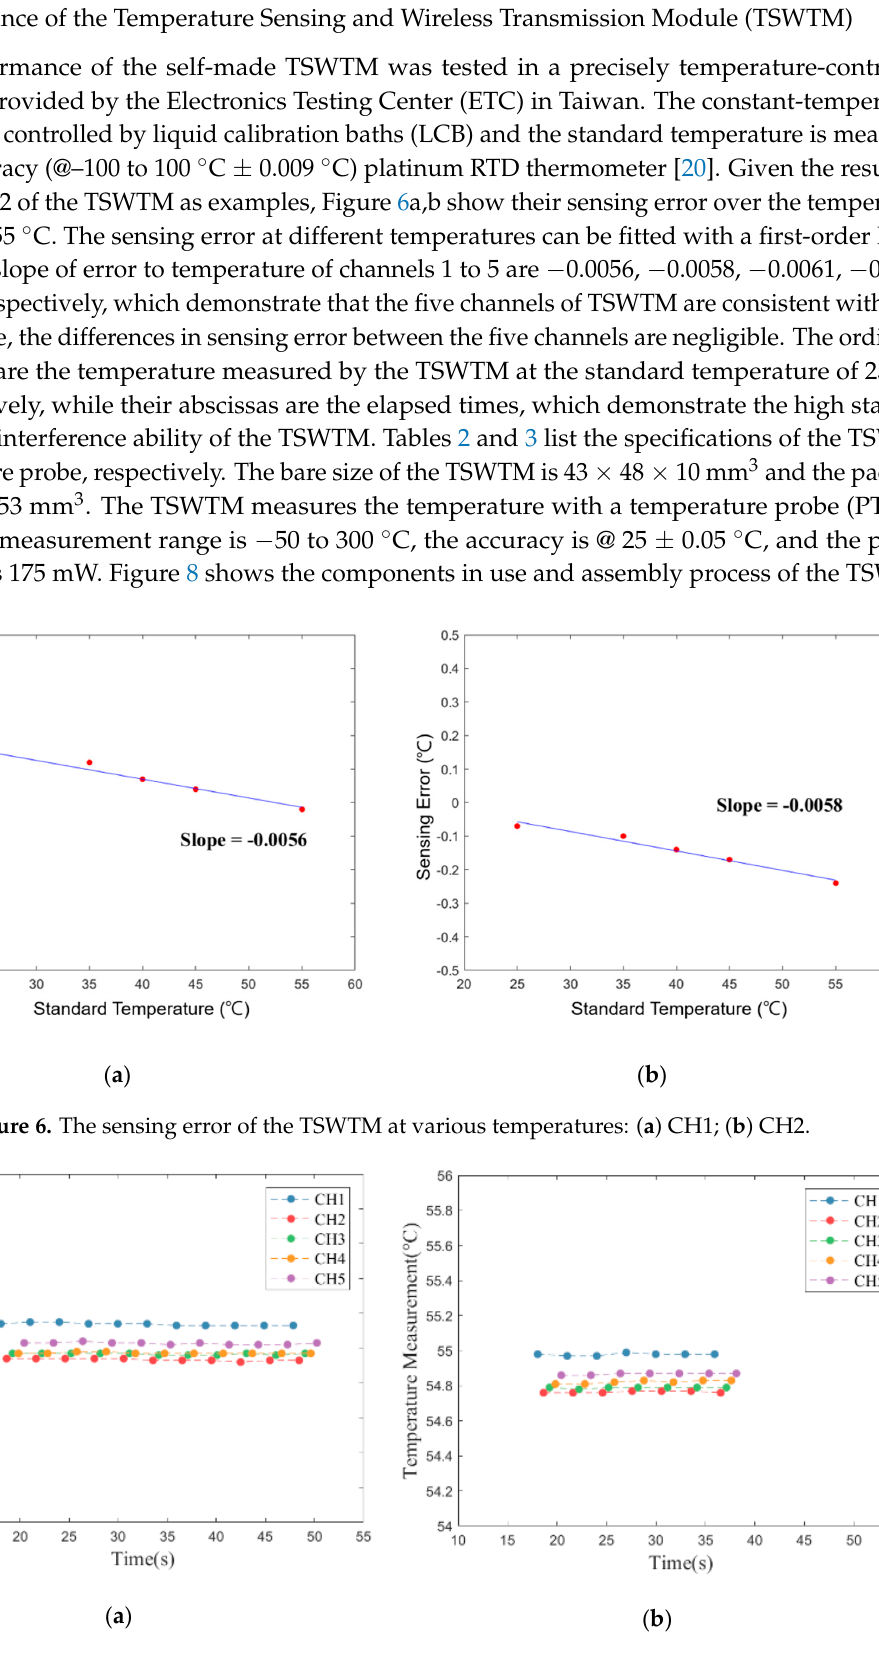
Figure 7. Temperature measurement of the TSWTM elapsing a time-period at constant temperature: